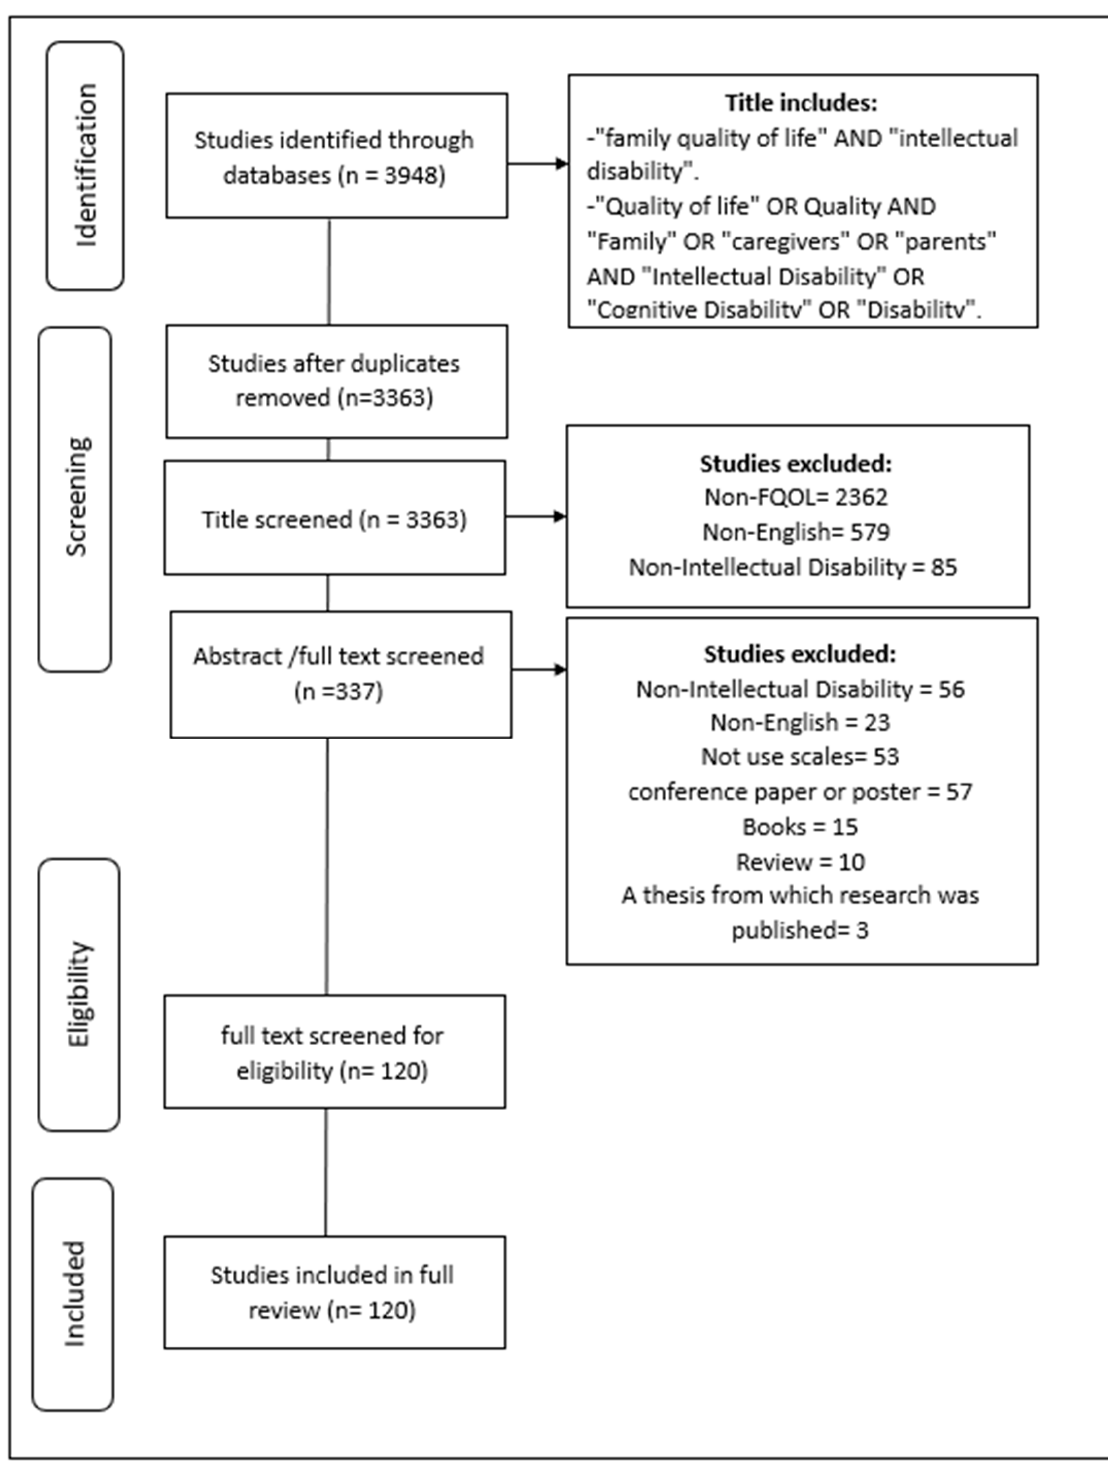
Figure 1. Steps of the data extraction.